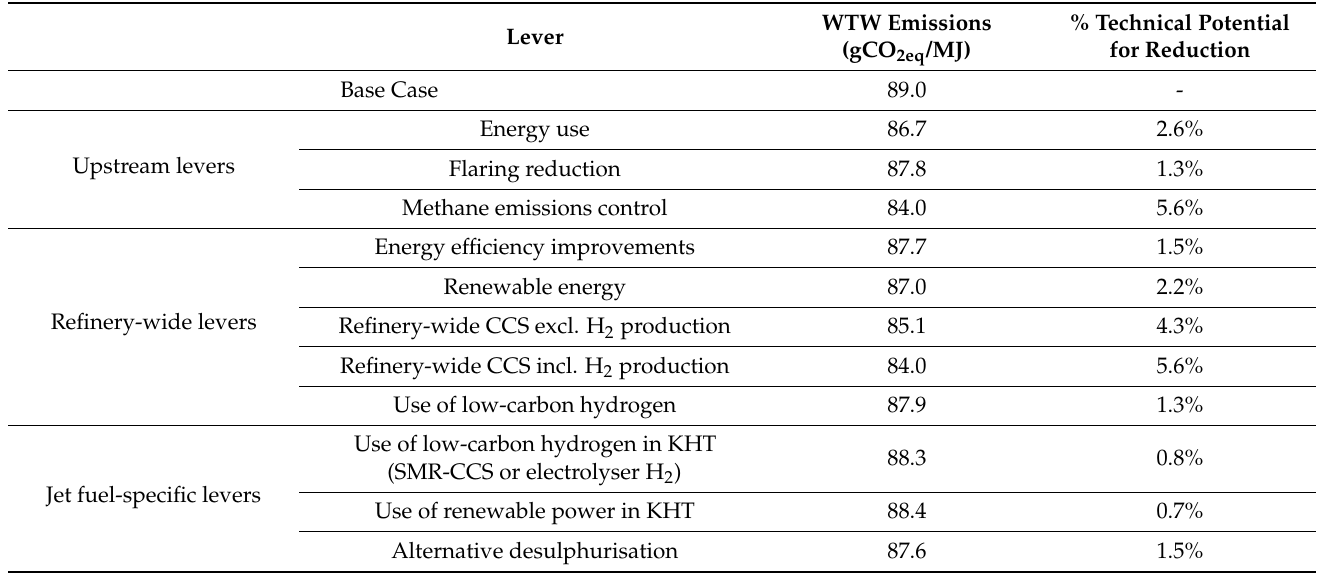
Table 7. Summary of WTW emissions of jet fuel arising from each lever, and the percentage reduction compared to the base case